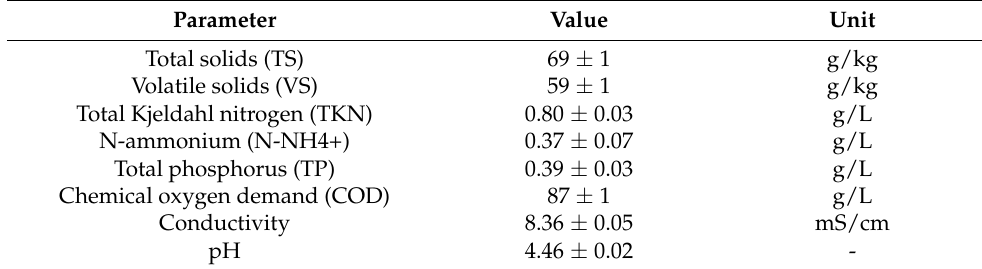
Table 1. The physicochemical characterization of CW.